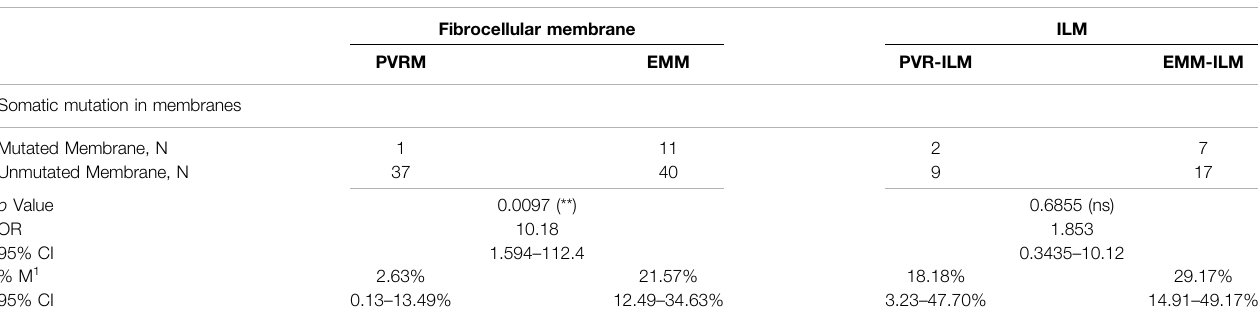
TABLE 3 | Somatic mutation at the MDM2 T309G locus in all membrane samples.